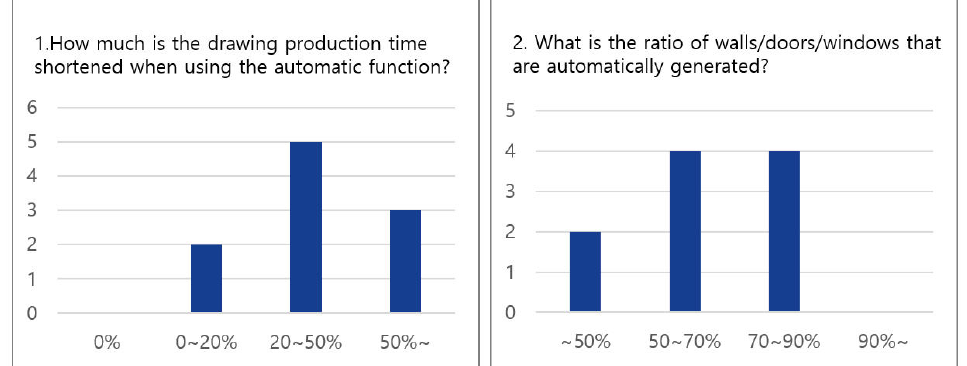
Figure 14. Ensemble methods usability survey